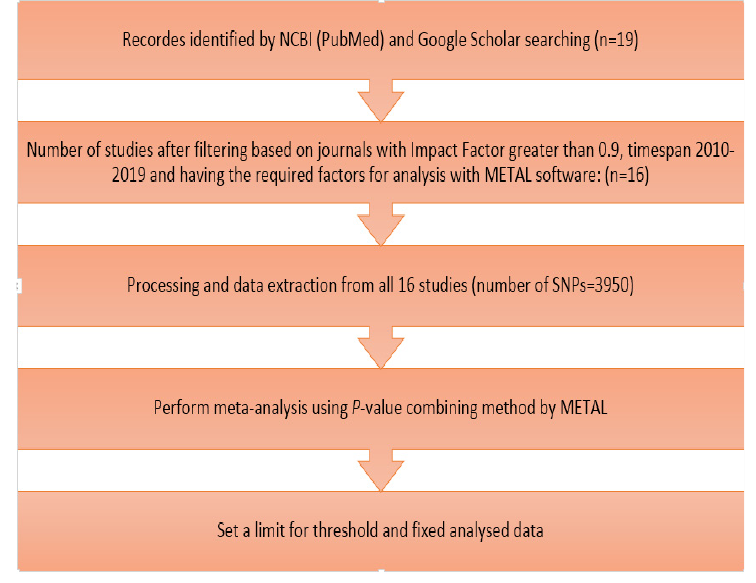
Figure 1. Flowchart of the meta-analysis of milk yield.